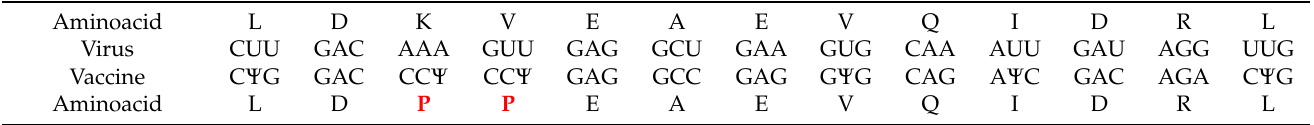
Table 1. Example of amino-acid modification on the mRNA sequence of Pfizer/BioNtech ® . The red bold color indicates the modified